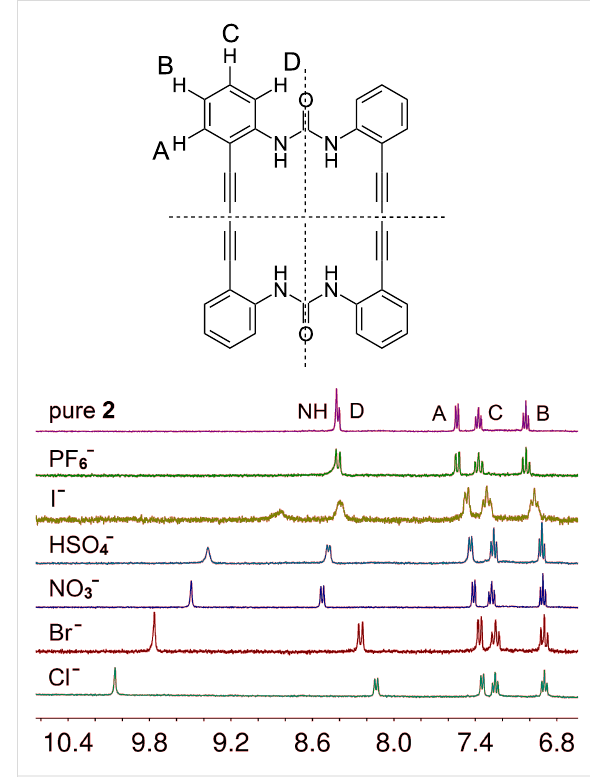
Figure 3: 1 H NMR spectra of 2 in THF- d 8 after addition of several different tetrabutylammonium salts. The N − H proton resonances show a distinct dependence on the kind of the present